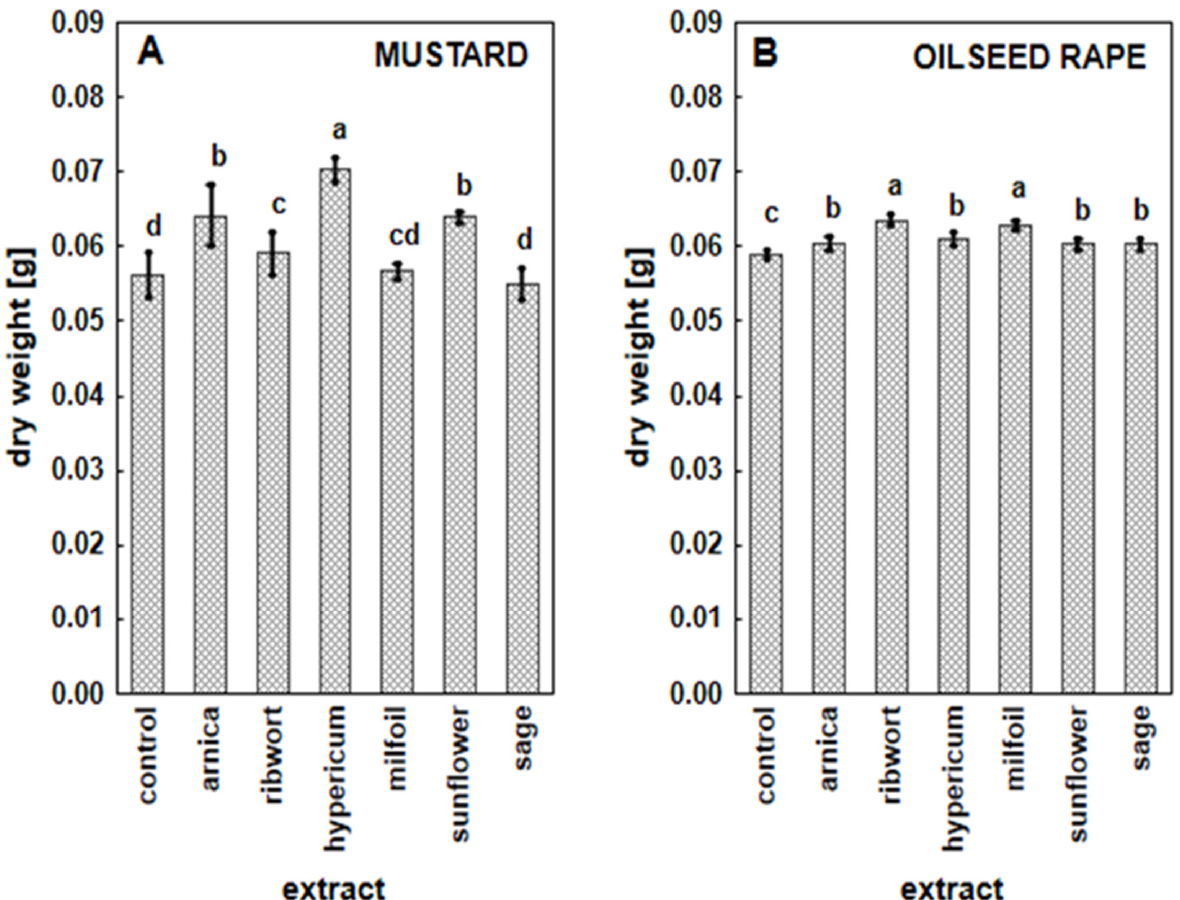
Figure 3. Dry weight of the three-day-old seedlings of white mustard ( A ) and oilseed rape ( B ) that were growing on the 10% ( w / v ) extracts from arnica, ribwort, hypericum, milfoil, sunflower, sage and water (control). The mean values ± SD indicated by the same letters did not differ significantly at p ≤ 0.05 according to the Duncan’s test (within the tested species), n = 20. Because the observed changes in dry weight did not reflect the visual variation in the size of the seedlings, the dry weight parameter cannot be a good indicator for determining the impact of allelopaths on plant metabolism unless we incorrectly conclude that the higher accumulation of biomass in the treated plants is an indicator of the negative (growth inhibitory) effects of allelopathics. On the other hand, we have to remember that under natural conditions, the reduction in plant growth that is observed from allelopathic effects may be caused by the competition among plants for water, minerals, oxygen or space for their root system. Other factors that contribute to limiting growth are changes in pH or the osmotic potential of the soil, which is caused by the decomposition of plant residues. There are many influencing factors, which is why most of the information regarding allelopathy still comes from studies that are based on biological assays (bioassays)